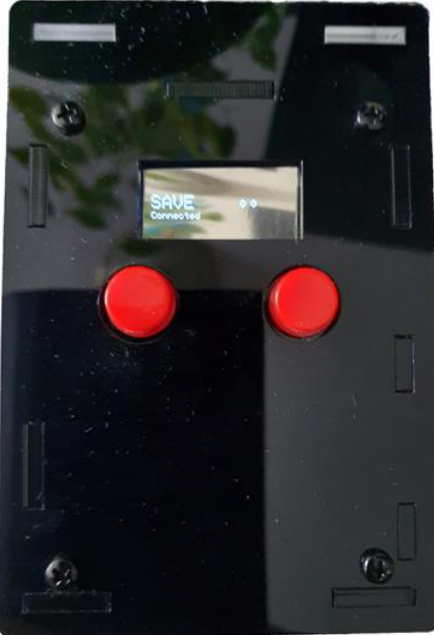
Figure 3. Automation sample.